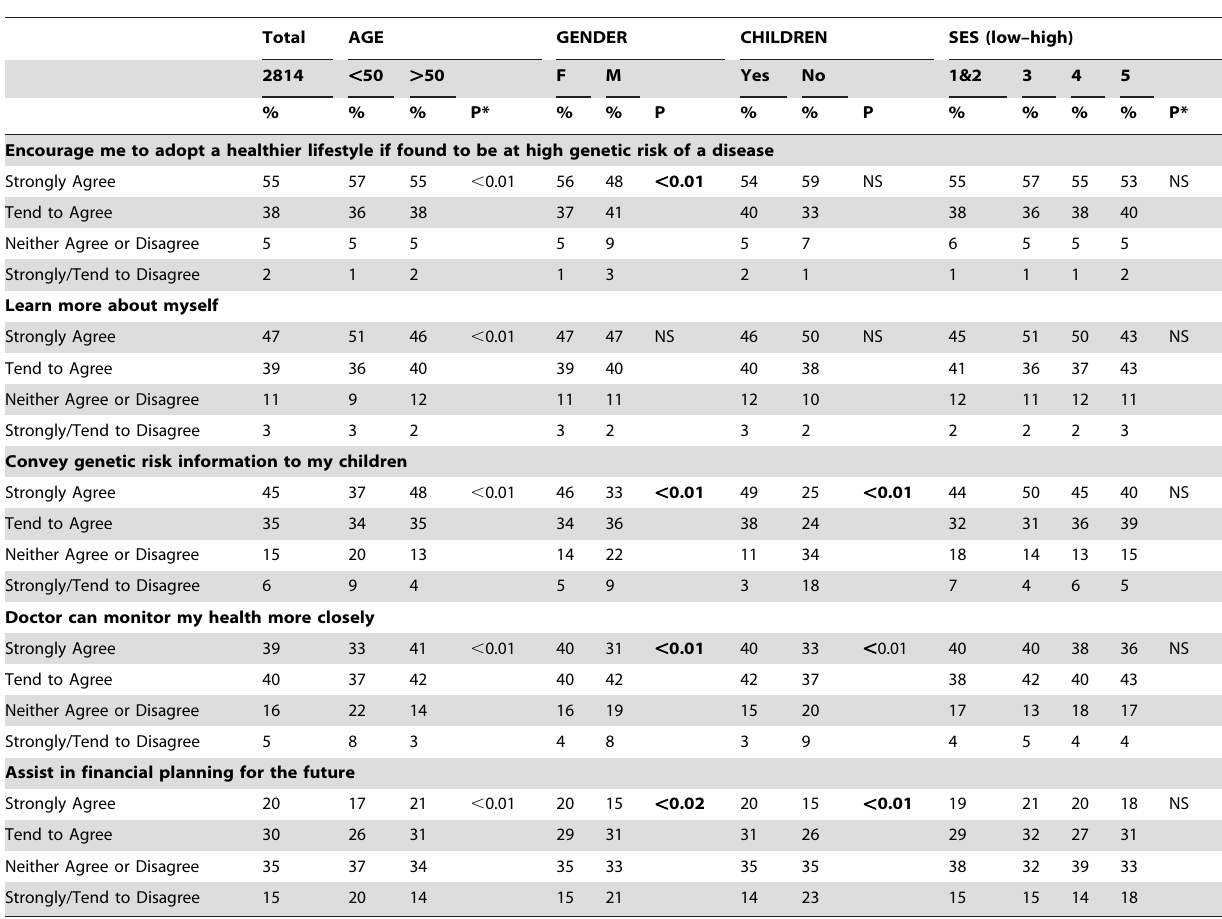
Table 3. Reasons to take a Personal Genetic